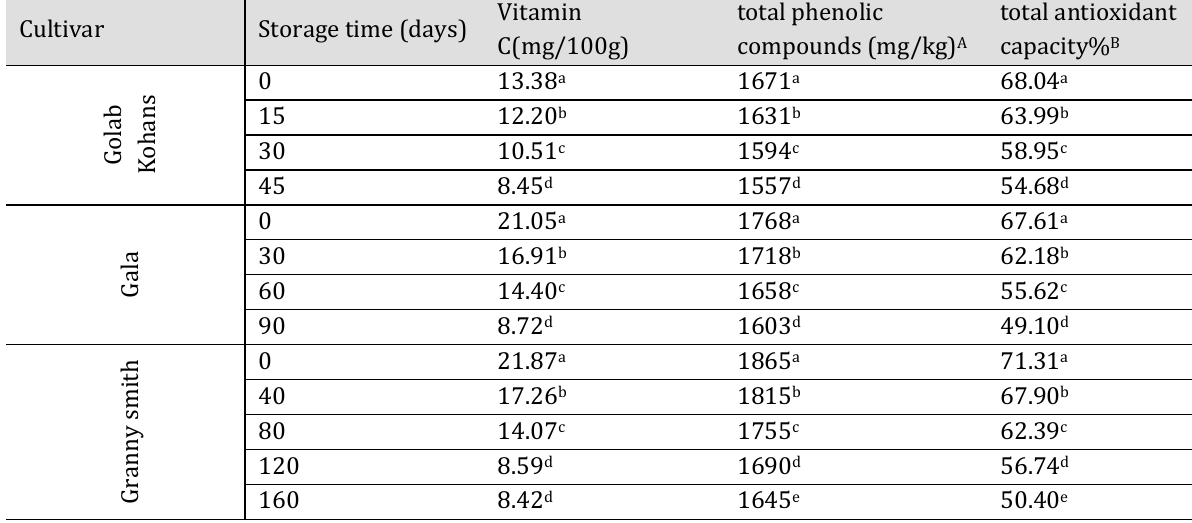
Table 2. The changes in vitamin C content (mg/100g) , total phenolic compounds (mg/kg), and total antioxidant ○ capacity (%) during cold storage period at 0±1 C and 90 - 95% relative humidity for three apple cultivars (‘Golab Kohans’, ‘Gala’ and ‘Granny